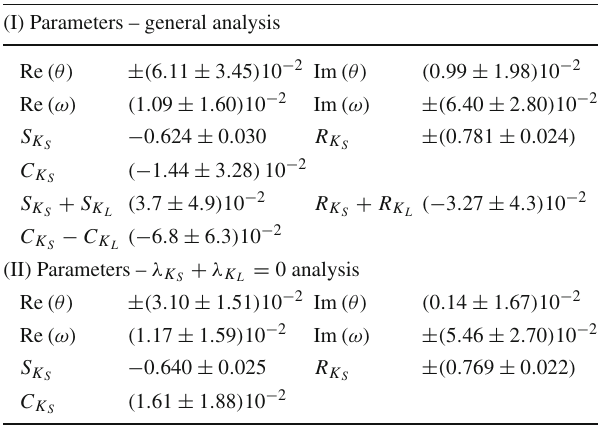
Fig. 1 Im (ω) vs. Re (ω) in the general fit (blue regions with solid + λ = 0 (red regions with dashed contours), and in the fit with λ K K L S contours); darker to lighter regions correspond to two-dimensional 68, 95 and 99% CL. Figures 3 and 4 obey the same colour coding for the two fits and the CL regions Table 1 Summary of